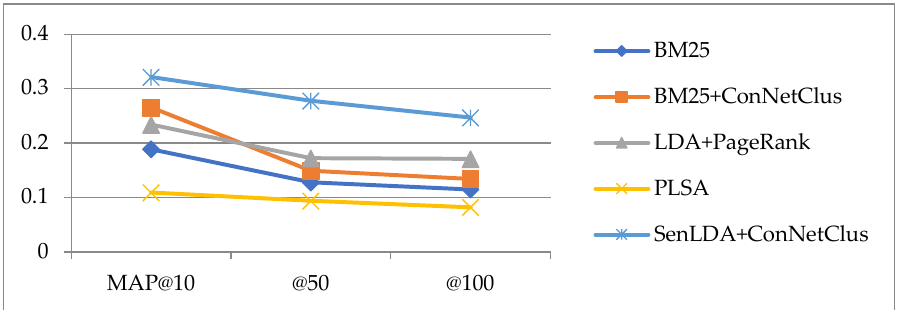
Table 4. Experimental results of NDCG.